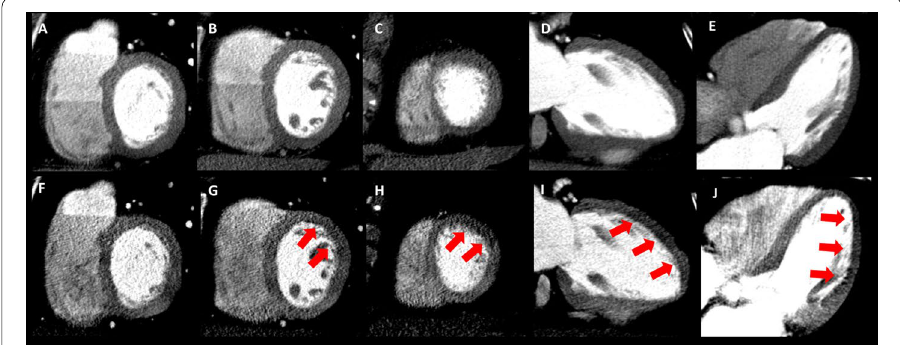
Fig. 2 CT-MPI Rest-Stress visual analysis. CT-MPI in Rest ( A – E ) and Stress ( F – J ) in short axis, 2-chamber and 4-chamber multi-planar planes images with 5–7 mm slice thickness, display 200–300 HU window width and 100–150 HU window length. Perfusion defects on post dipyridamole stress CT-MPI in mid and apical anterior/ anterolateral segments in a single patient (red arrows on G – J ). The extent and severity of stress perfusion defect was scored as 1 for mid anterior segment, 2 mid anterolateral segment, 3 for apical anterior segment and 1 apical lateral segment. This corresponded to summed stress score of 7, summed rest score of 0 and sTPD 10%, iTPD 10%. TPD total perfusion